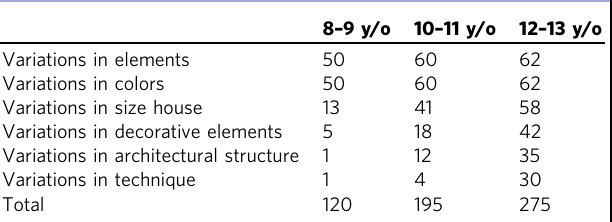
Table 2 Frequencies of pictorial strategies used in each drawing by age